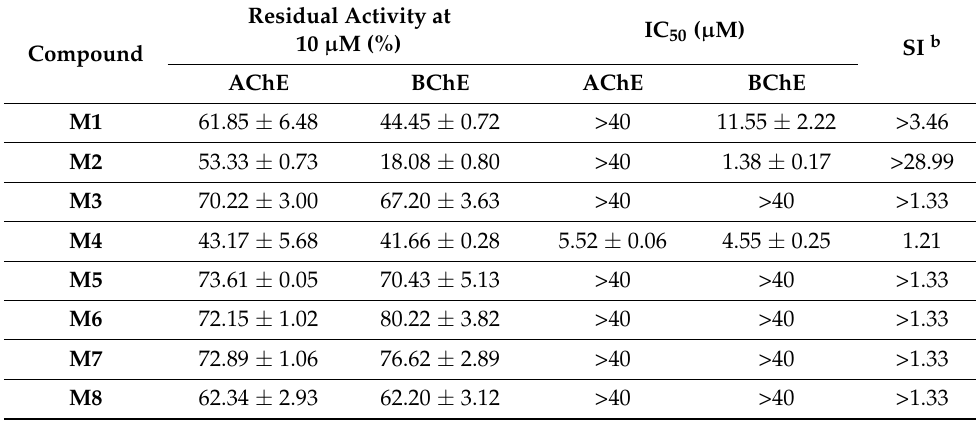
Table 2. Inhibitions of ChE by the M series a